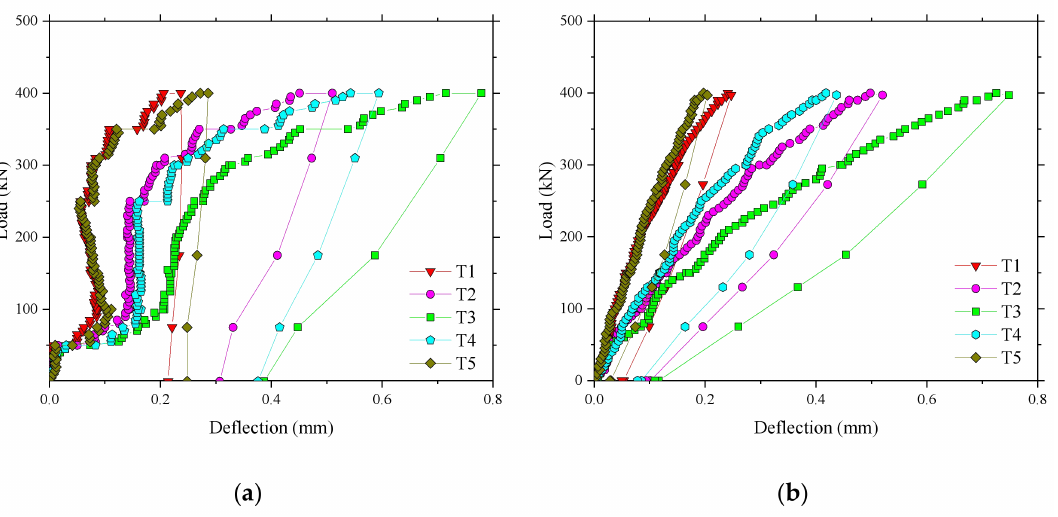
Figure 7. Deflection of different positions in the test areas. ( a ) Deflection for the test region 2; ( b ) Deflection for the test region 4.